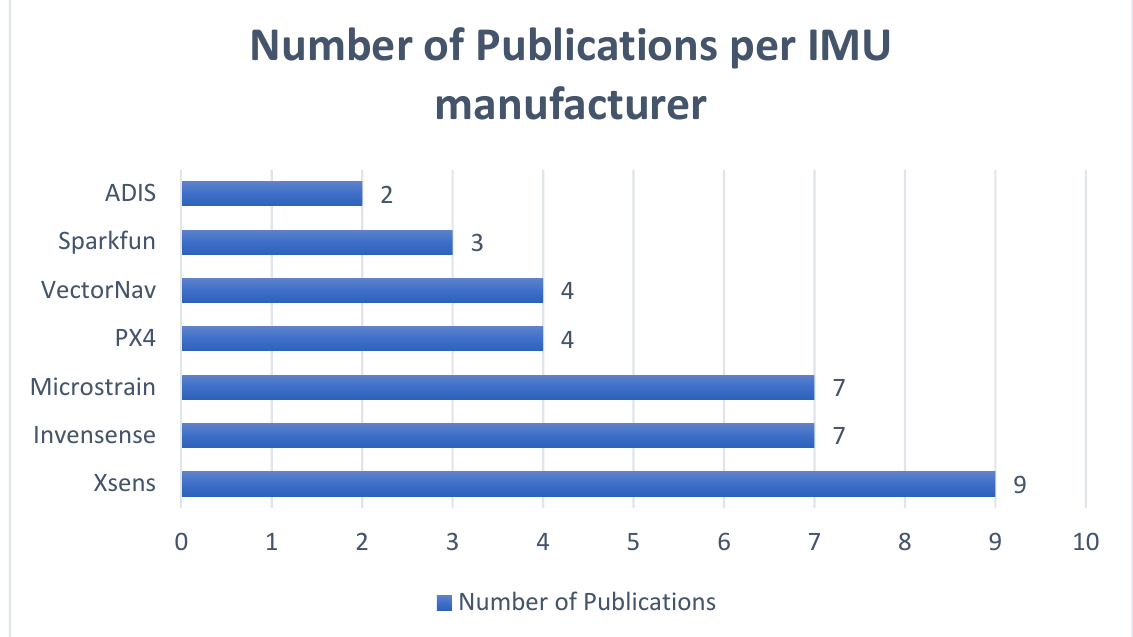
Figure 1. Publications per IMU manufacturer.